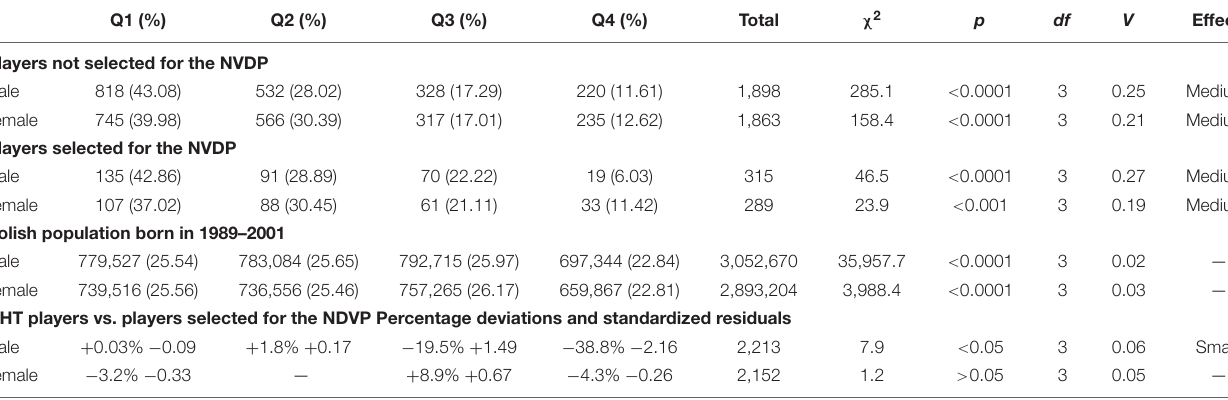
TABLE 1 | Analysis of birth-date distribution by quarter of the year among Polish elite youth volleyball